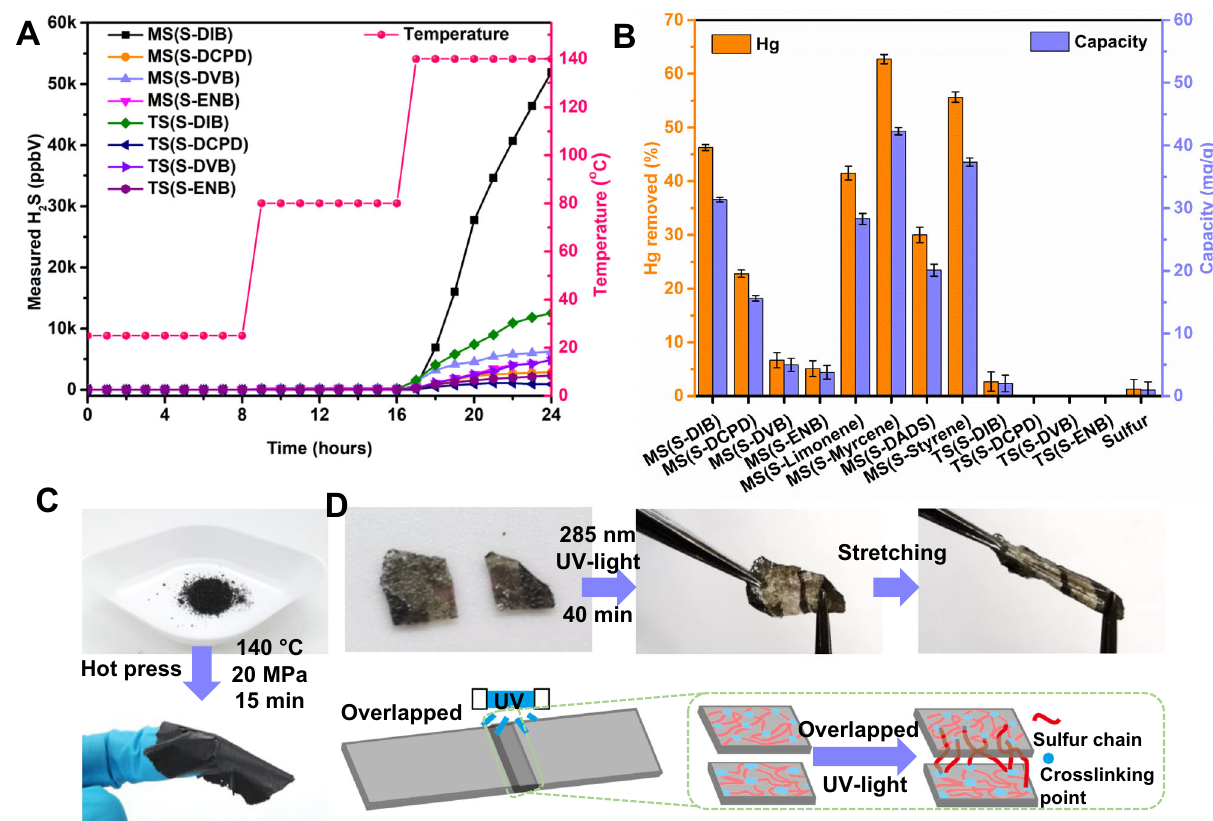
Fig. 3 | H 2 S measurements and potential application explorations. A H 2 S mea- surements on selected mechanochemically synthesized and thermally synthesized polymerswithrampingtemperatureatroomtemperature,80°Cand140°C. B The percentage mercury removed from 138 ppm HgCl 2 solution after 24h exposure to each of the materials listed, and the capacity of mercury removing of each of the